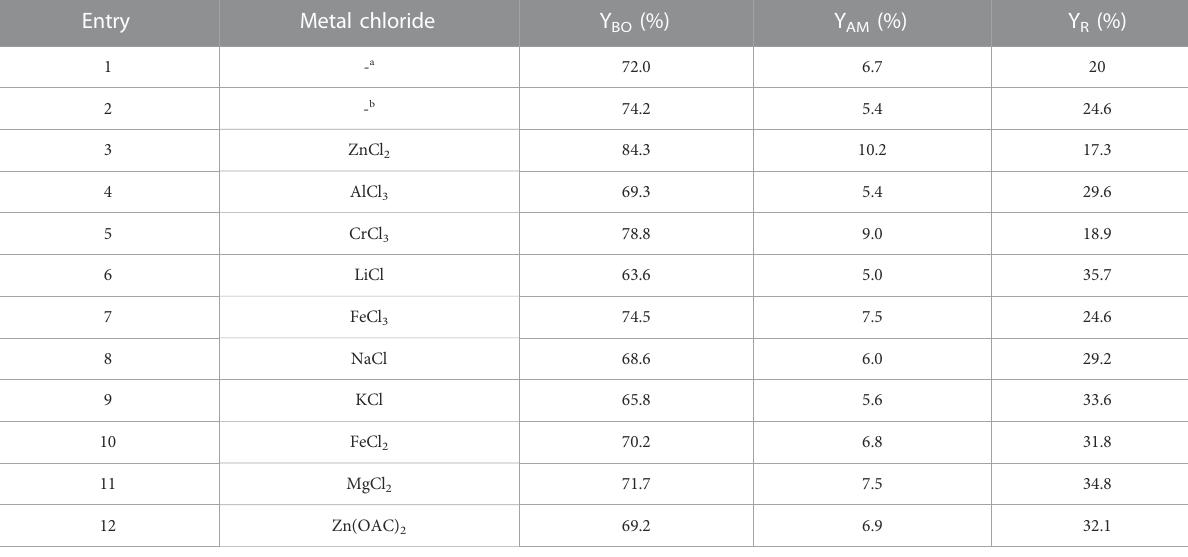
TABLE 1 The effect of different metal chloride on the products of lignin depolymerization. Entry Metal